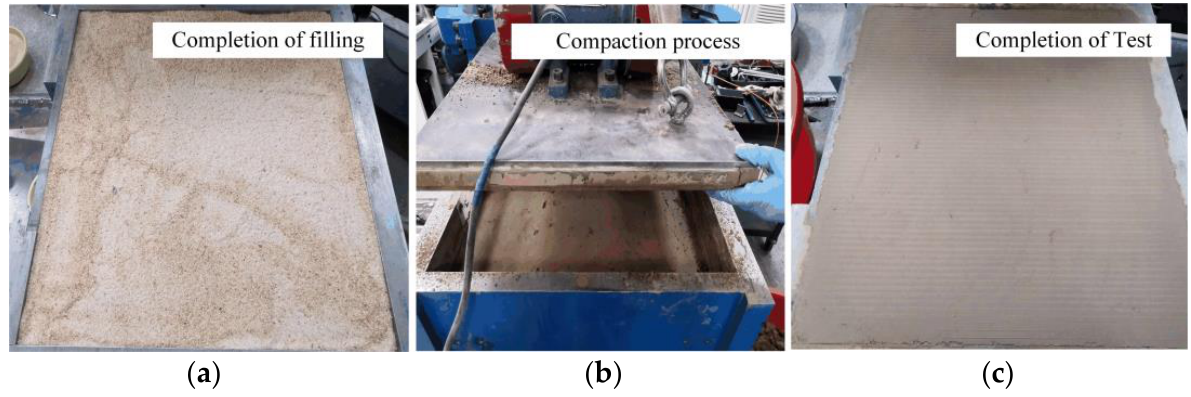
Figure 4. Process of shear test: ( a ) completion of filling; ( b ) compaction process; ( c ) completion of test.